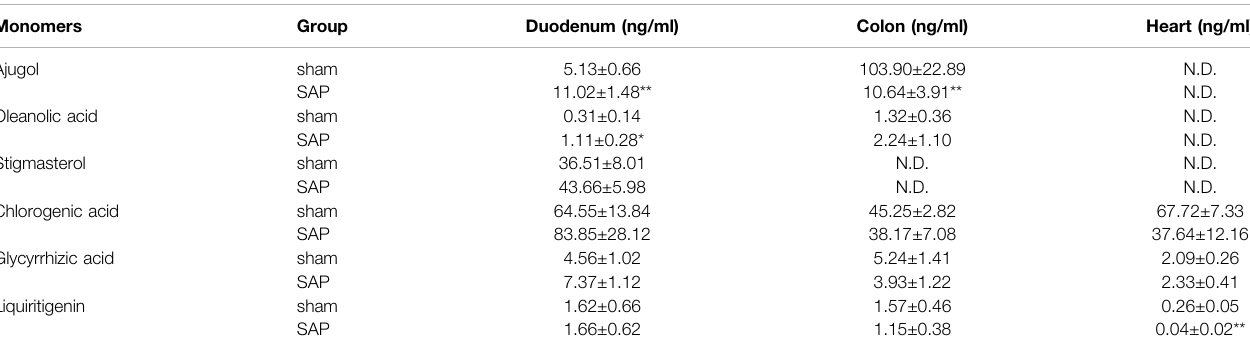
Sham, sham operation group; SAP, Sever acute pancreatitis group; N.D., Not detected; * p < 0.05, ** p < 0.01 vs.